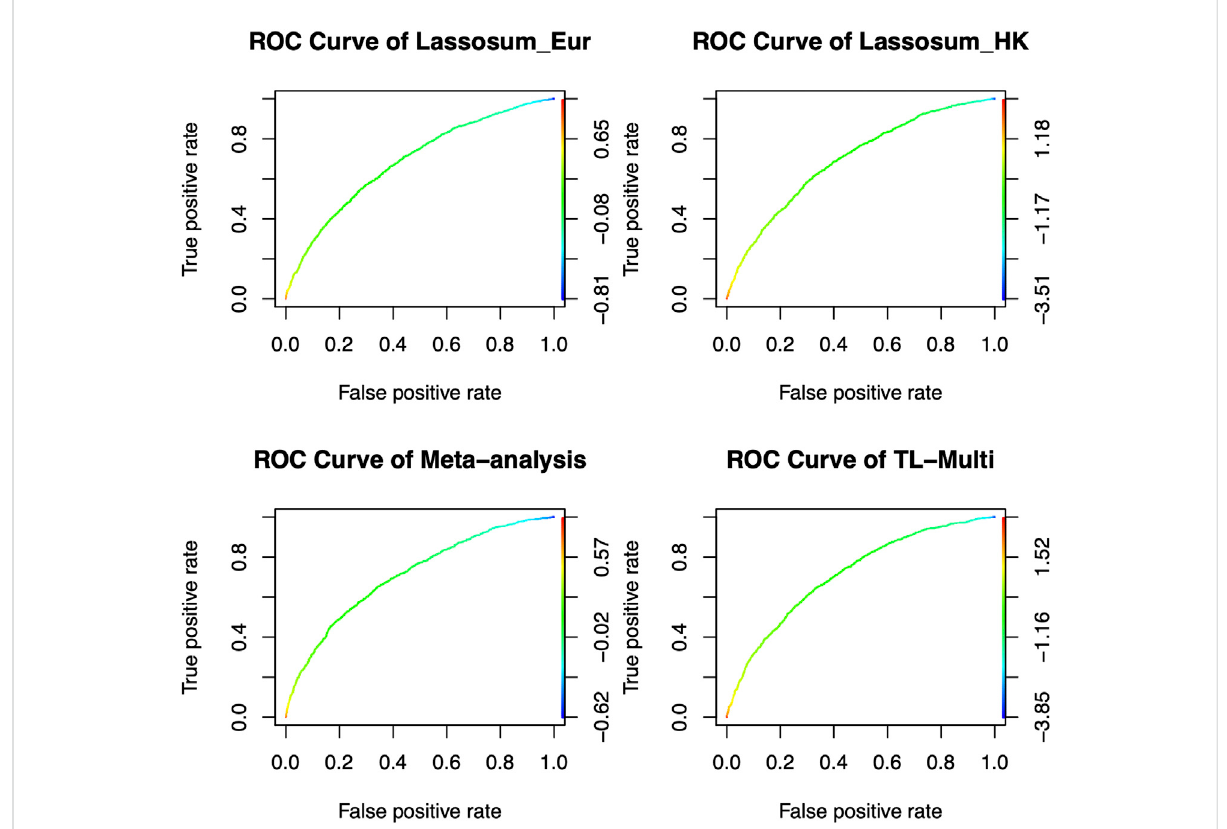
FIGURE 3 ReceiveroperatingcharacteristiccurveofLassosum,meta-analysis,andTL-MultiintheanalysisofSLEstudy.Lassosum_HKisLassosum forthe Hong Kong population, and Lassosum_Eur is Lassosum for the European population. The corresponding AUC values with the optimal PRS of